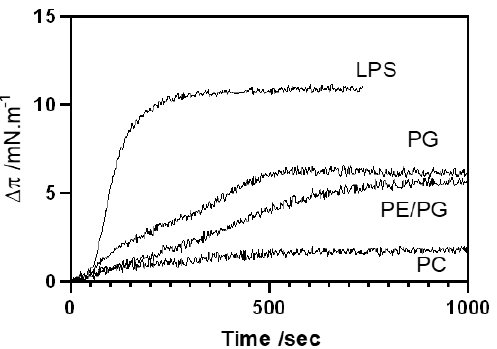
* Monolayers mimic the outer membrane of Gram- (LPS), the cytoplasmic membrane of Gram- (POPE/POPG 6:4), or of Gram+ (POPG), or the eukaryotic membrane (POPC). ** Increase in pressure measured 25 min after peptide injection. Peptide structures in Table 1. Results are the average of three independent experiments (error < 10%).